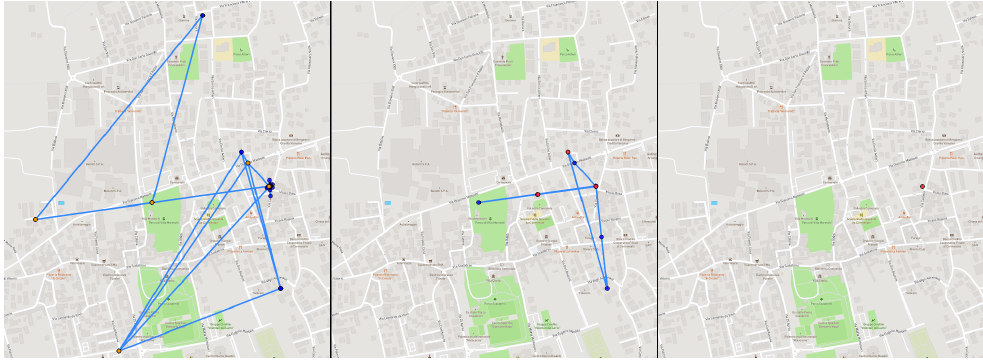
Figure 10. Multi-clustering. Raw ( left ), first iteration ( center ), second iteration ( right